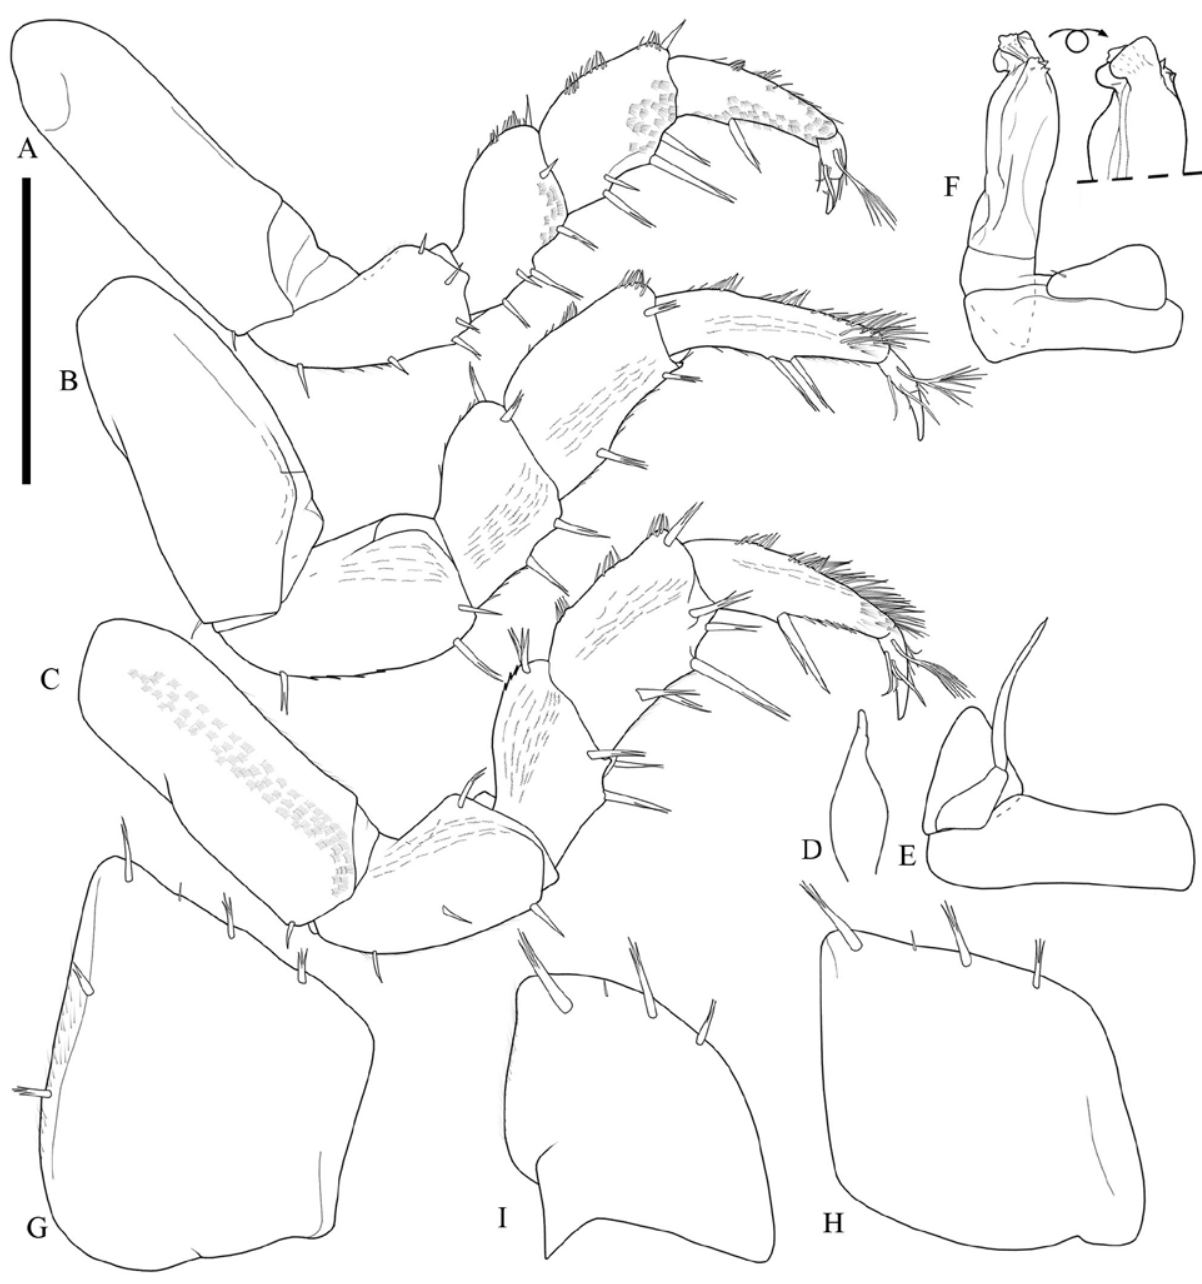
Figure 2. Pectenoniscus montalvaniensis n. sp. Male paratype: A , pereopod 1; B , pereopod 6; C , pereopod 7; D , genital papilla; E , pleopod 1; F , pleopod 2; G , pleopod 3 exopod; H , pleopod 4 exopod; I , pleopod 5 exopod. Scale bar: 0.2